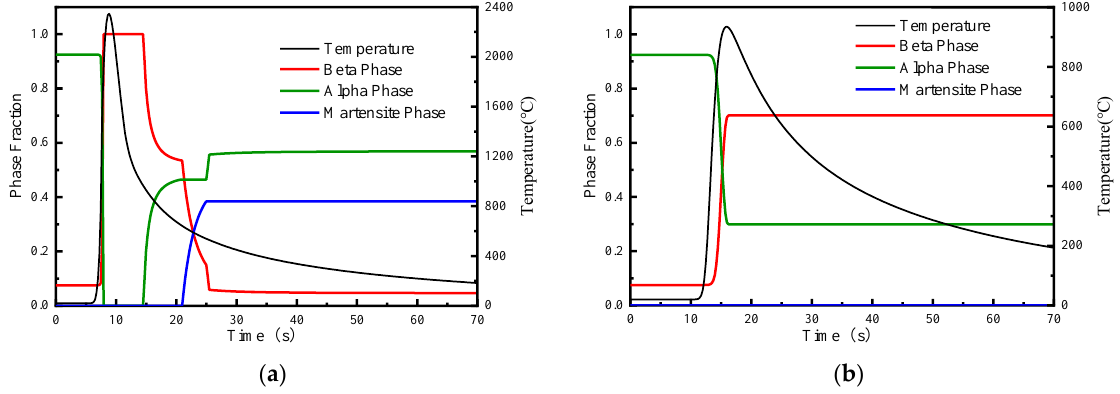
Figure 21. Change of phase volume fraction in weld area of TIG weldment: ( a ) FZ zone, ( b ) PM/HAZ interface.